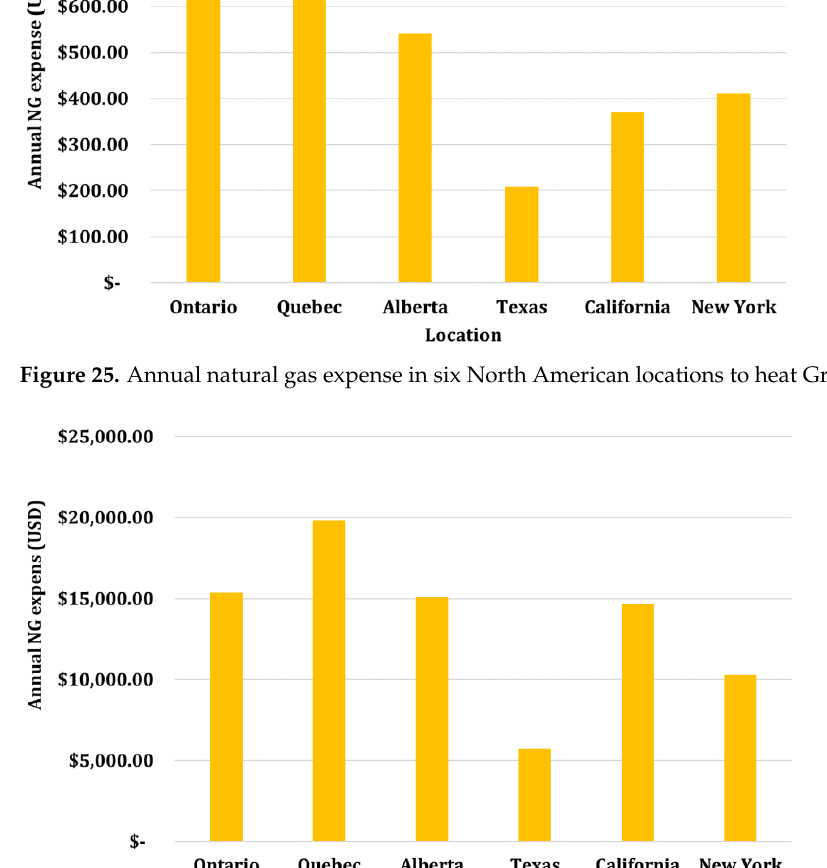
Figure 26. Annual natural gas expense in six North American locations to heat Greenhouse 2.